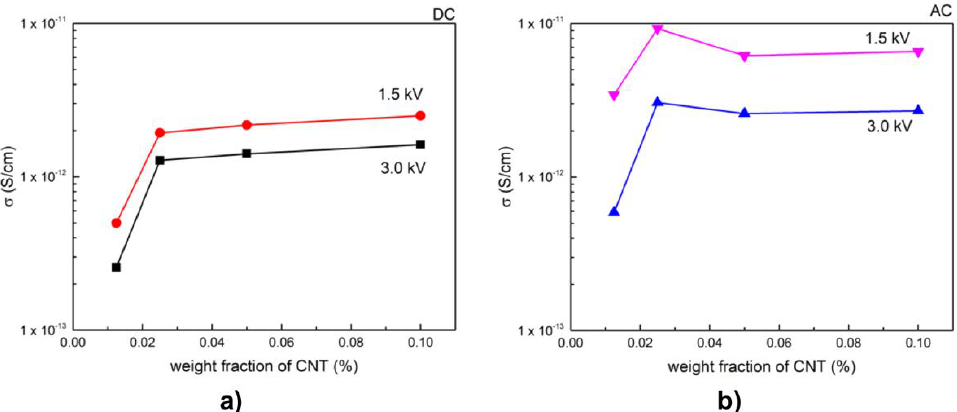
Figure 38. Electrical conductivities of polycarbonate/CNT composites as a function of nanotube weight fraction; ( a ) DC, ( b ) AC. Data extracted from [111].